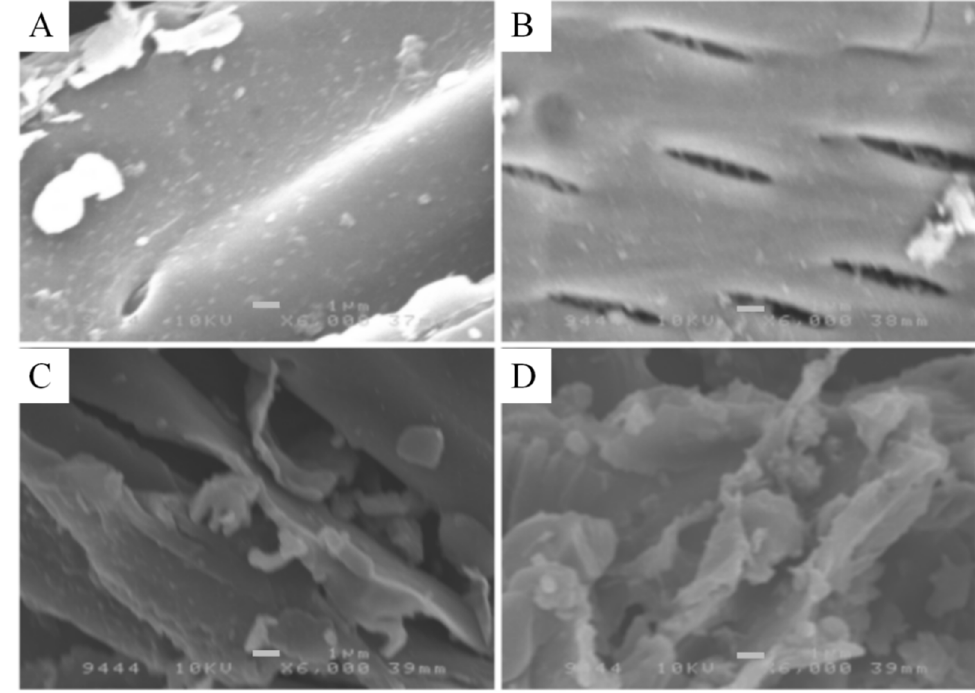
Figure 7. SEM images of biochar and control group: ( A ) Raw BW; ( B ) Residue of 160 ℃ , 30 min; ( C ) Biochar from raw BW; ( D ) Biochar from residue of 160 ℃ , 30 min.